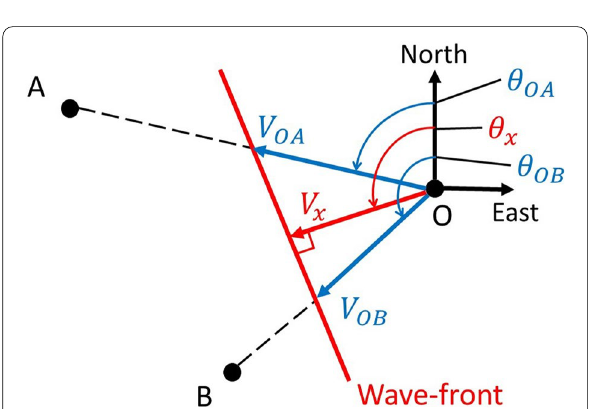
Fig. 4 Geometry of the propagation parameter calculation. V x and θ x are the propagation speed and direction, respectively. θ OA is the anti-clockwise azimuthal angle of OA from the geographic north and θ OB is that of OB. V OA = d OA / LAG2, V OB = d OB / LAG1 , where d OA is the distance from O to A, d OB is the distance from O to